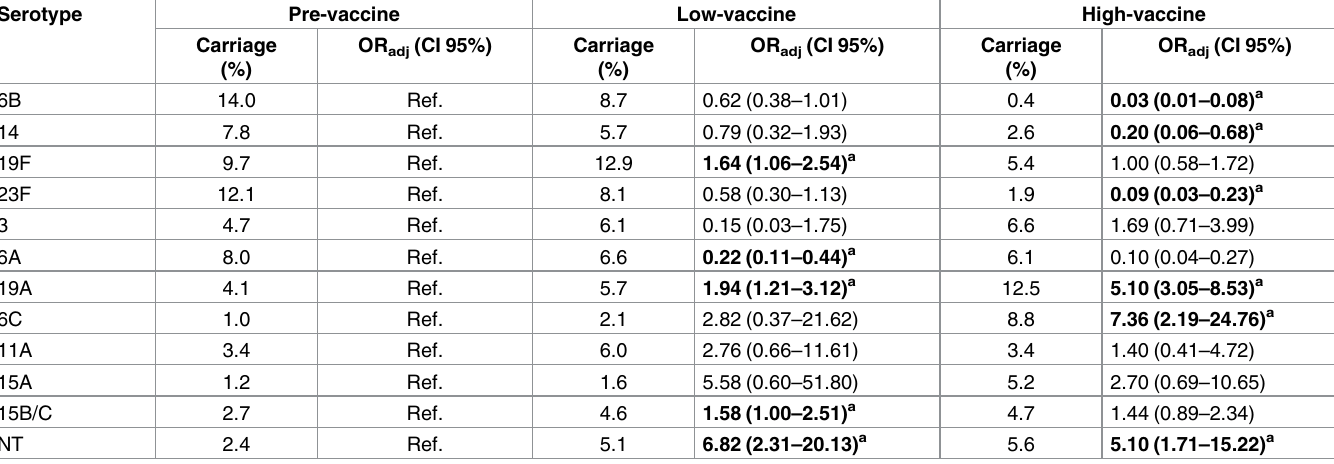
Table 2. Effect of PCV7 coverageon carriageof PCV7 and non-PCV7 serotypes.